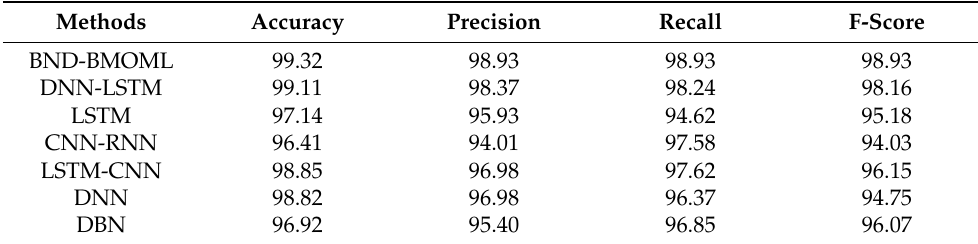
Table 5. Comparative analysis of BND-BMOML approach and recent algorithms.